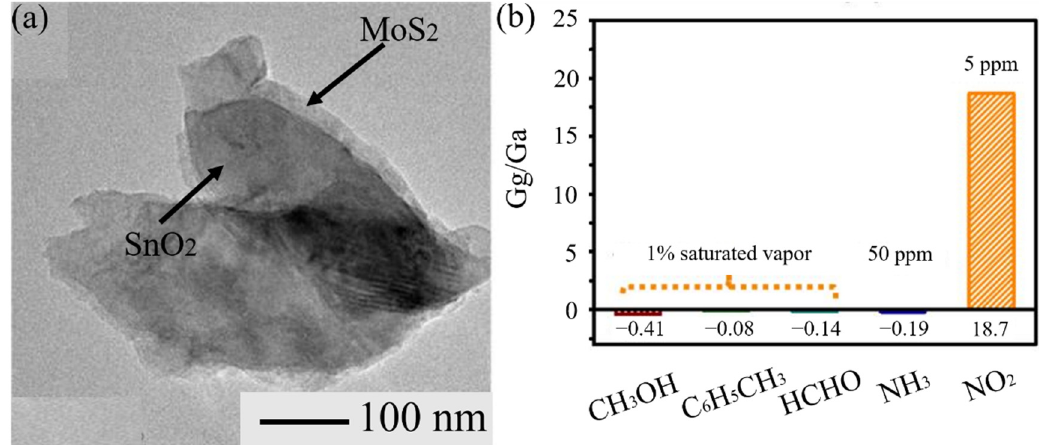
Figure 11. MoS 2 -SnO 2 heterostructure gas sensor. Adapted from [137] copyright (2019), with permission from Elsevier. ( a ) The morphology of MoS 2 -SnO 2 heterostructure; ( b ) the response of MoS 2 -SnO 2 heterostructure to NO 2 .